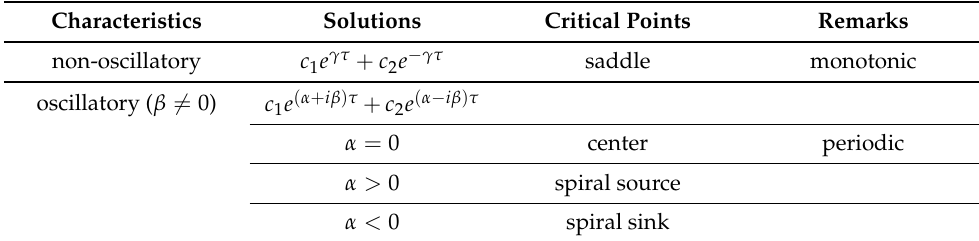
Table 1. The classification of various types of solutions for a linear 2D system with real coefficients. We assumed an arbitrary α , β > 0, and γ >